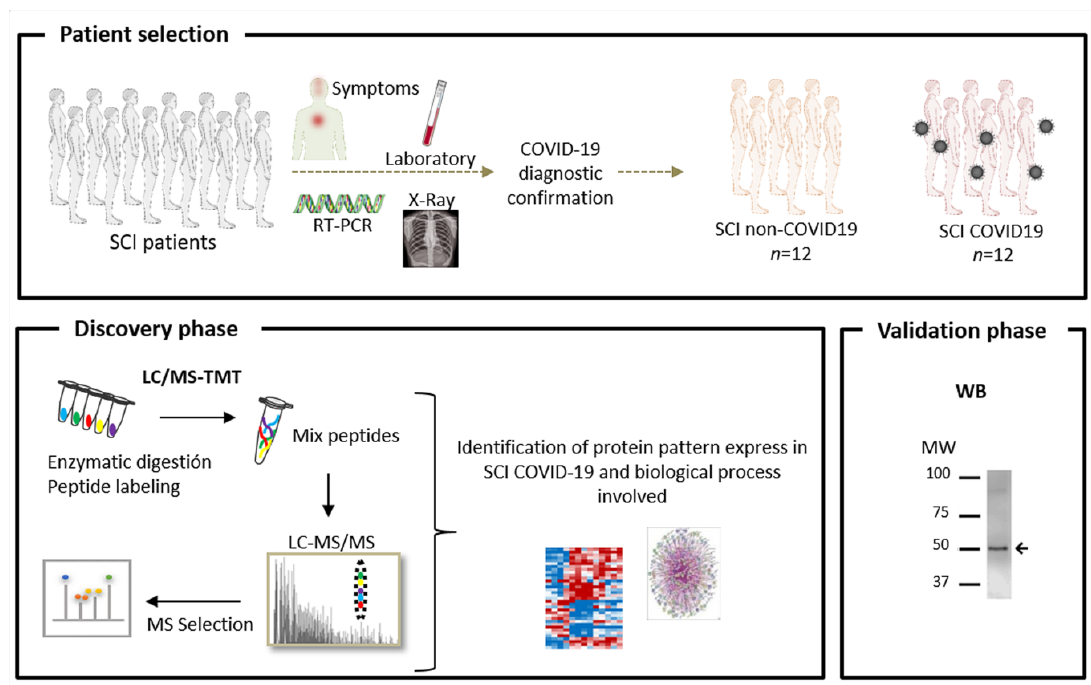
Figure 1. Schematic representation of the workflow. Plasma samples were collected from patients with spinal cord injury (SCI) with and without confirmed COVID-19 infection. The experimental design consists of a discovery phase using TMT labelling, followed by LC-MS/MS and a confirmation phase employing Western blotting (WB).